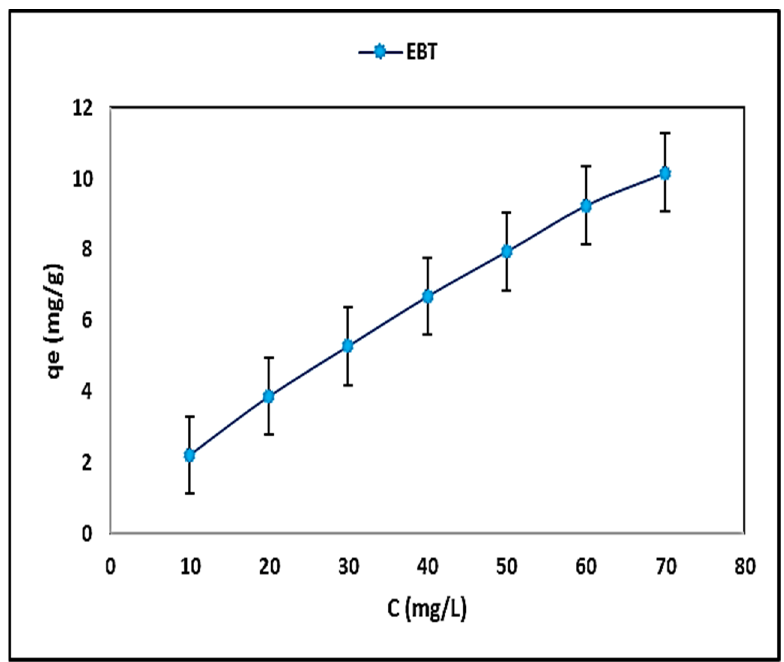
Figure 9. Effect of initial concentration of EBT dye adsorption by activated carbon of cannabis ( t = 90 min, T = 20 ± 1 °C, adsorbent dose 10 mg, stirring= 150 rpm and pH = 7 ± 0.2).